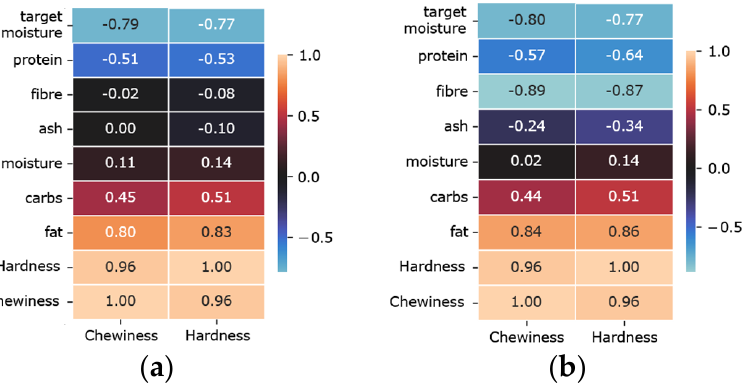
Figure 8. Correlation scores between ingredients and textural properties. ( a ) Before removal of Faba Bean Concentrate Commercial (FBC-com); ( b ) after removal of FBC-com.